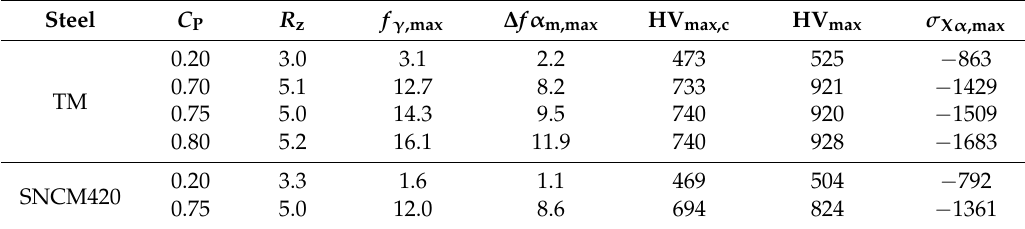
Table 3. Measured surface-hardened layer properties of TM and SNCM420 steels subjected to vacuum-carburization under various carbon potentials and subsequent fine-particle